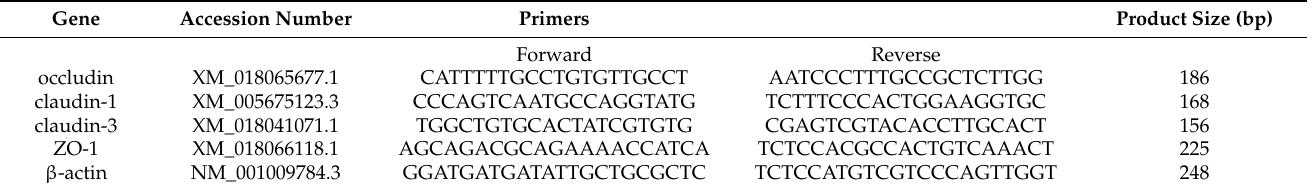
Table 1. The primer information for the